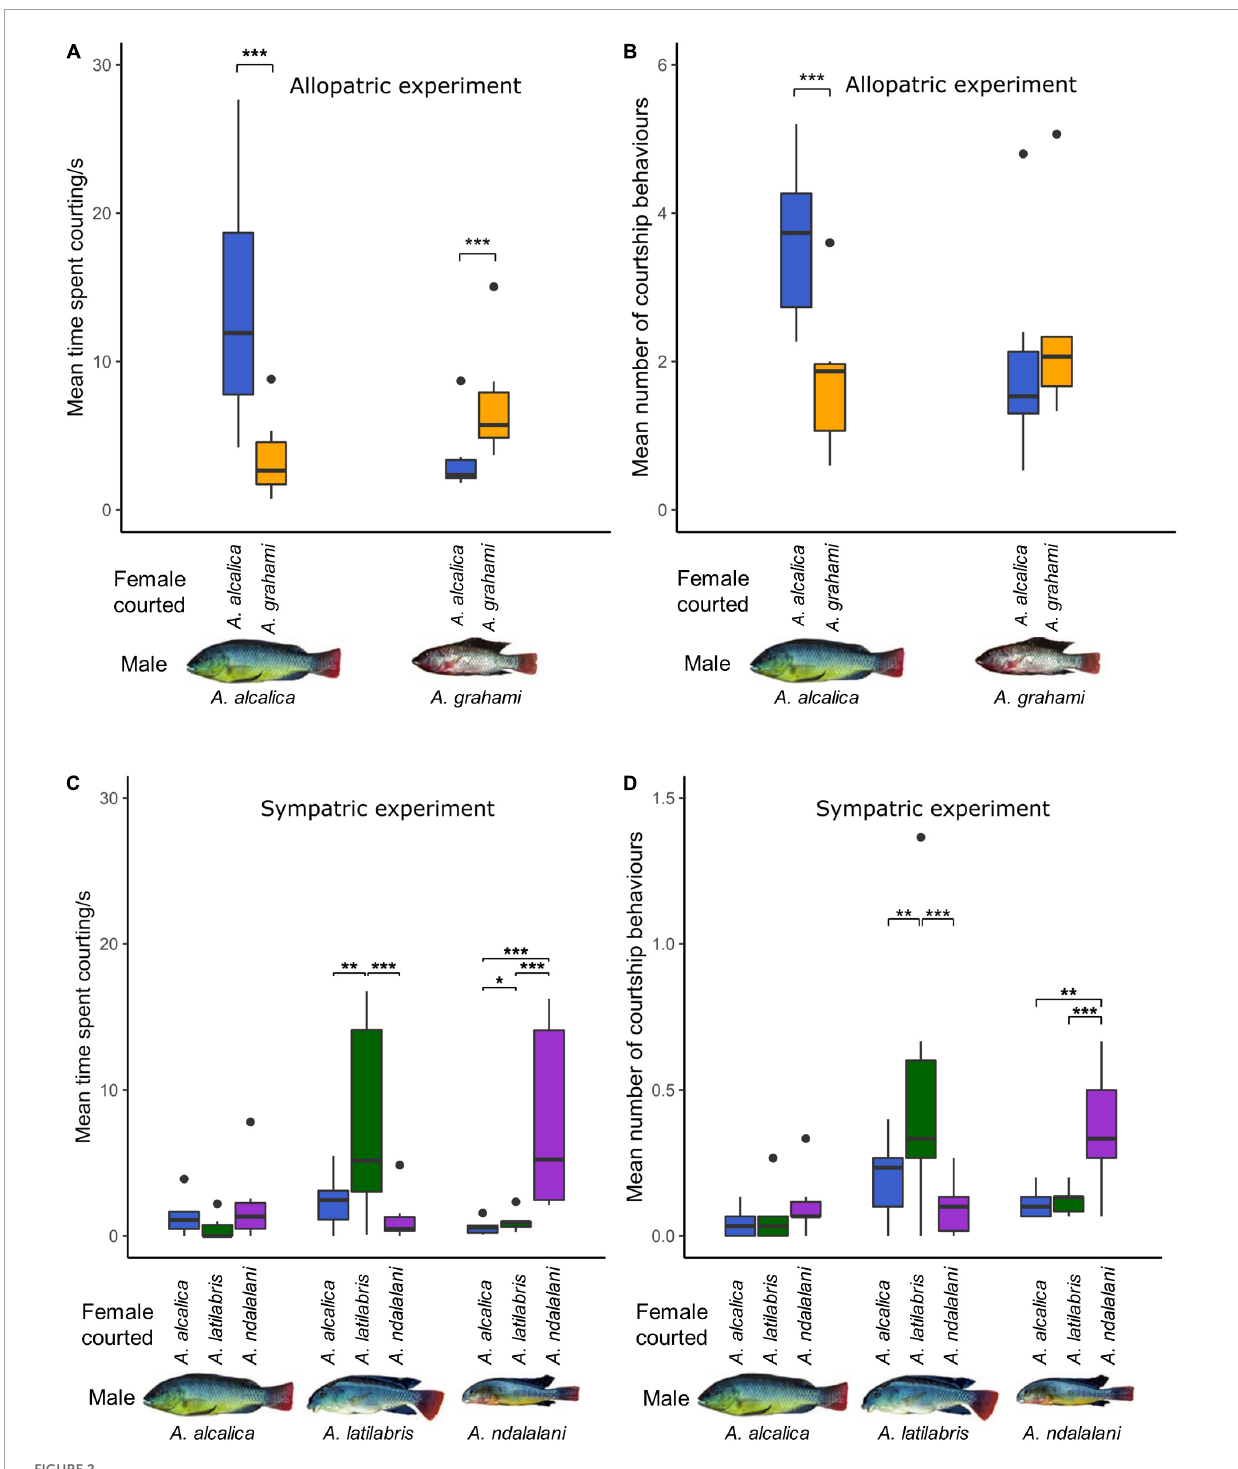
FIGURE2 Male courtship with conspecific and heterospecific females in Alcolapia ; (A,C) time spent courting and, (B,D) number of courtship attempts for each male during 5 min focal observations. Courtship results are shown for both the allopatric (A,B) and sympatric experiments (C,D) . Colors denote the species of female courted with: blue = A. alcalica , green = A. latilabris , purple = A. ndalalani , orange = A. grahami . Large outliers (35.4 and 57.6 s) were removed from panel (C) for clarity (see Supplementary Figure 1 for full figure). Asterisks denote significant levels of pairwise contrasts extracted from GLMMs: *** < 0.001, ** < 0.01, * < 0.05.